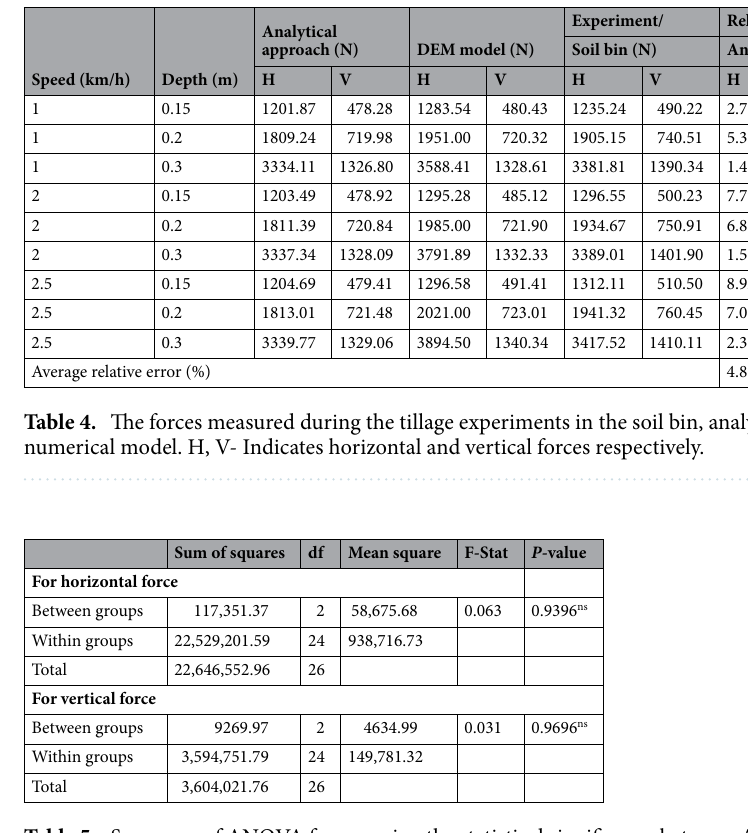
Table 5. Summary of ANOVA for assessing the statistical significance between Analytical model, DEM simulation, and soil bin experiment results. **, ns - Indicates significant at 0.05% level and non-significant,